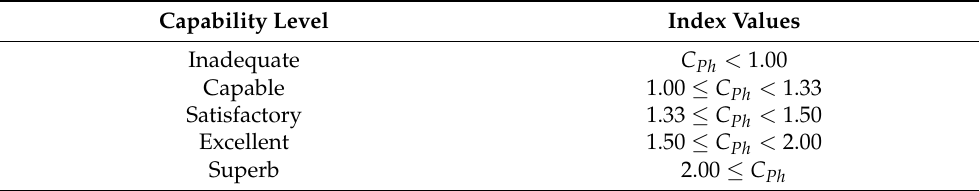
Table 1. The capability level and corresponding index